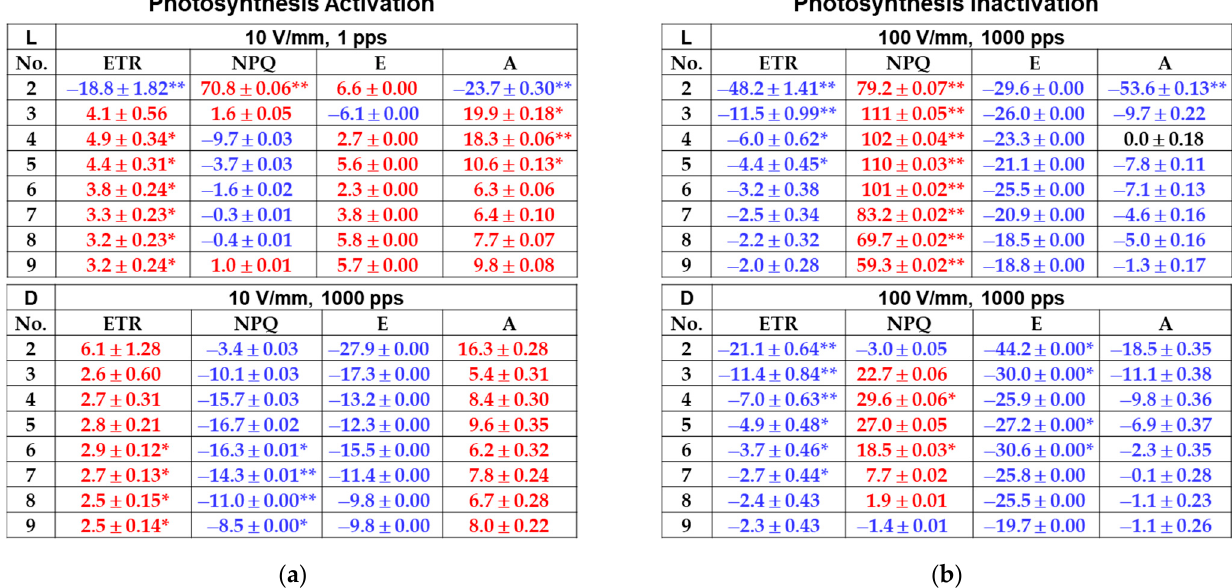
Figure 6. Characteristics of photosynthesis ( a ) activation and ( b ) inactivation after PEF treatments using the combined gas exchange and chlorophyll fluorescence measurements. Results used the average values of 15 samples for the control and 5 samples for each PEF-treated group. L: light-acclimated PEF samples; D: dark-acclimated PEF samples. Average values were calculated for photosynthesis measurement results obtained from each experiment, and the percentage of increase/decrease vs. the control group are listed. Increases are shown in red and decreases in blue. Standard error values and average values are also included. Asterisks (* and **) indicate significant differences for p < 0.05 and p < 0.01, respectively. In ( a ), photosynthesis activation, ETR and A increased and NPQ decreased. In ( b ), photosynthesis inactivation, ETR and A decreased and NPQ increased.